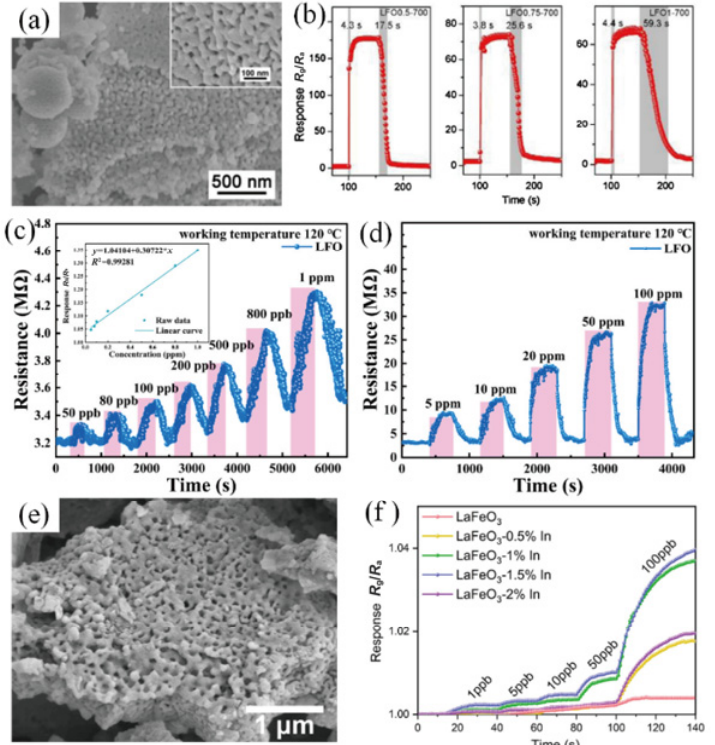
Fig. 7 (a) FESEM images of LaFeO 3 . (b) Response/recovery curves of sensors based on 100 ppm formaldehyde at the optimal operating temperature for different LaFeO 3 samples. (c, d) Dynamic response curves of LaFeO 3 thin film gas sensors toward 0.05–100 ppm. The inset of (c) is the linear fitting curve of gas sensor toward 0.05–1 ppm formaldehyde. (e) SEM image of In-doped LaFeO 3 . (f) Dynamic response curves of In-doped LaFeO 3 to 1–100 ppb. Reproduced with permission from Ref.